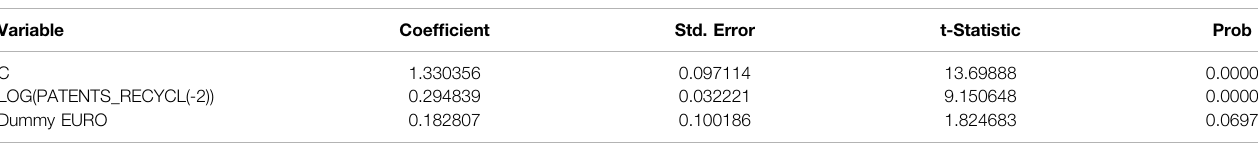
TABLE 8 | The estimated coef fi cients and statistical tests of Eq. 5 .